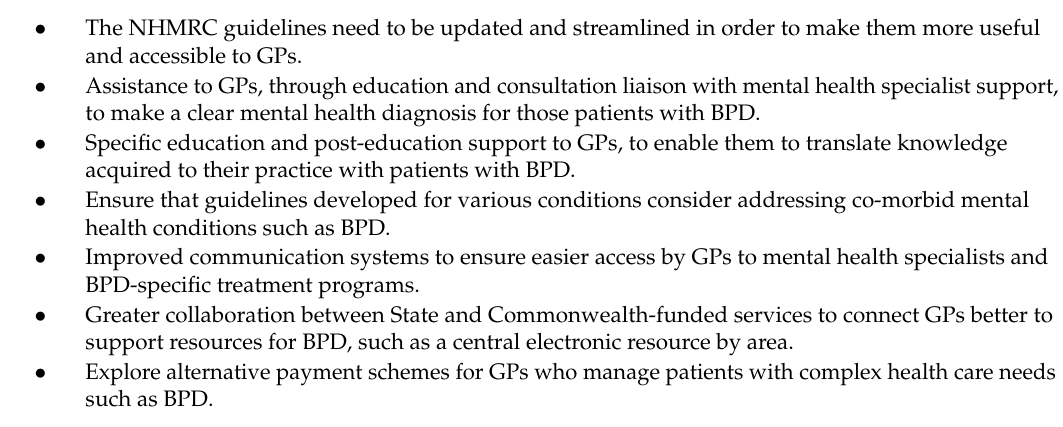
Table 4. Improvements Needed to Support GP Practice with Patients with